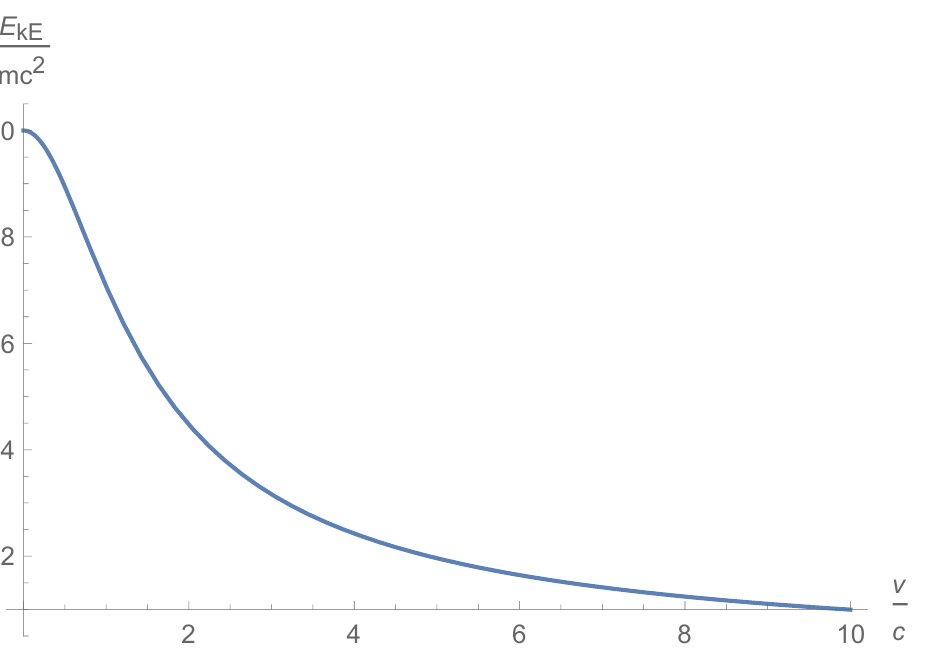
Figure 7. Kinetic energy for Euclidean particles, the correct expression (blue) is compared with the classical approximation (orange).